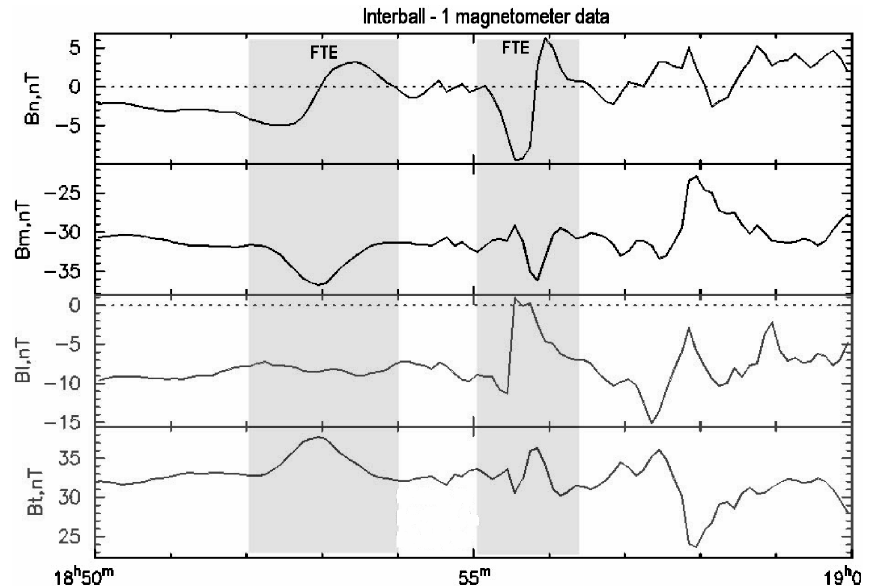
Fig. 4. Interball-1 magnetometer observations in LMN coordinates for the interval from 08:50 to 09:00UT on 11 September 1998. Of the three candidate FTEs during this interval, only those at 08:53 and 08:56UT satisfy the event identification criteria used in this